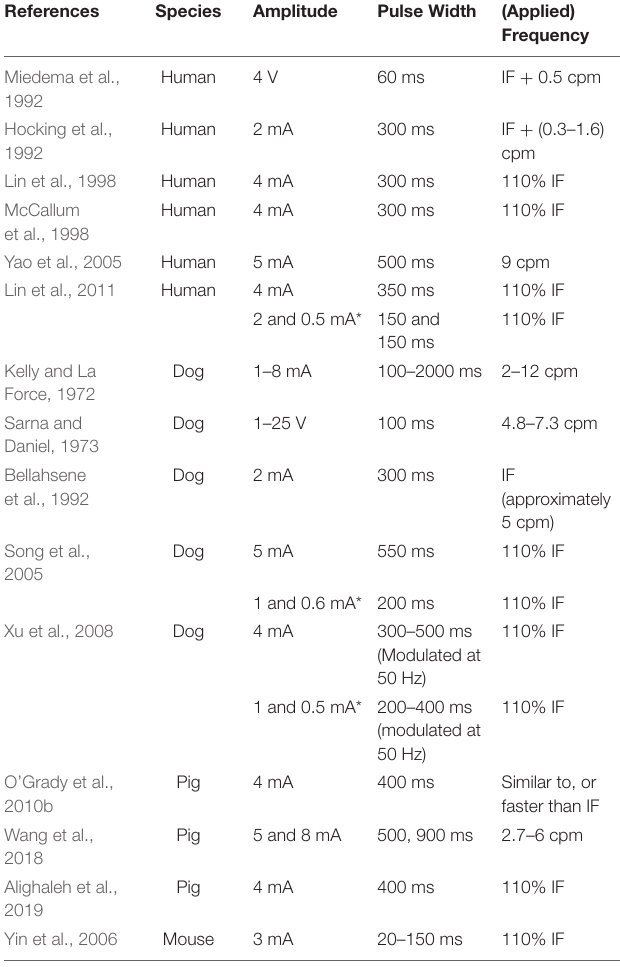
TABLE 1 | Protocols used for gastric